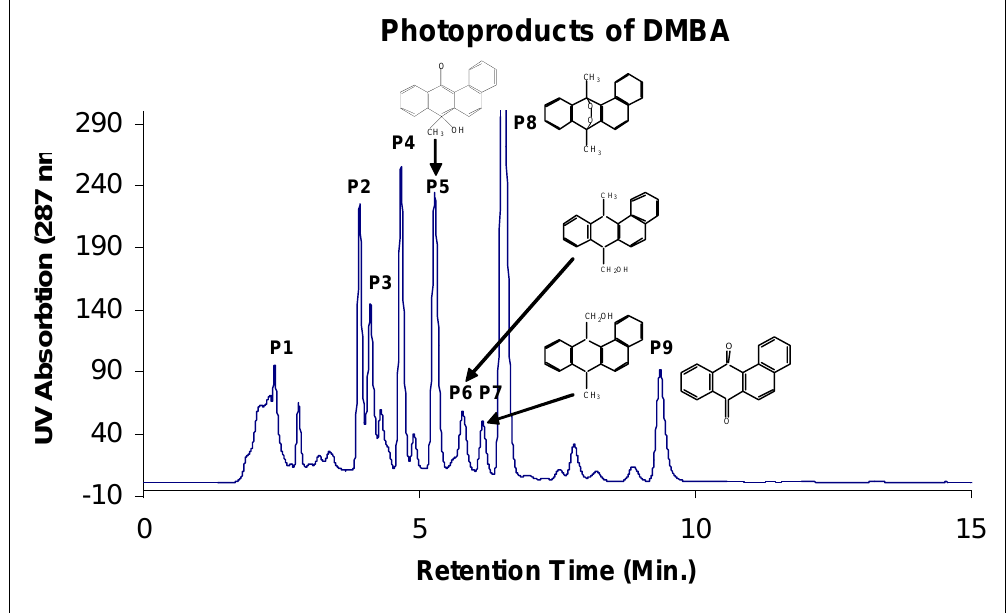
Figure 2: Identification of some of the photoproducts of DMBA in ethanol after 360 min of irradiation using UVA light (2.6 J/cm 2 /min).